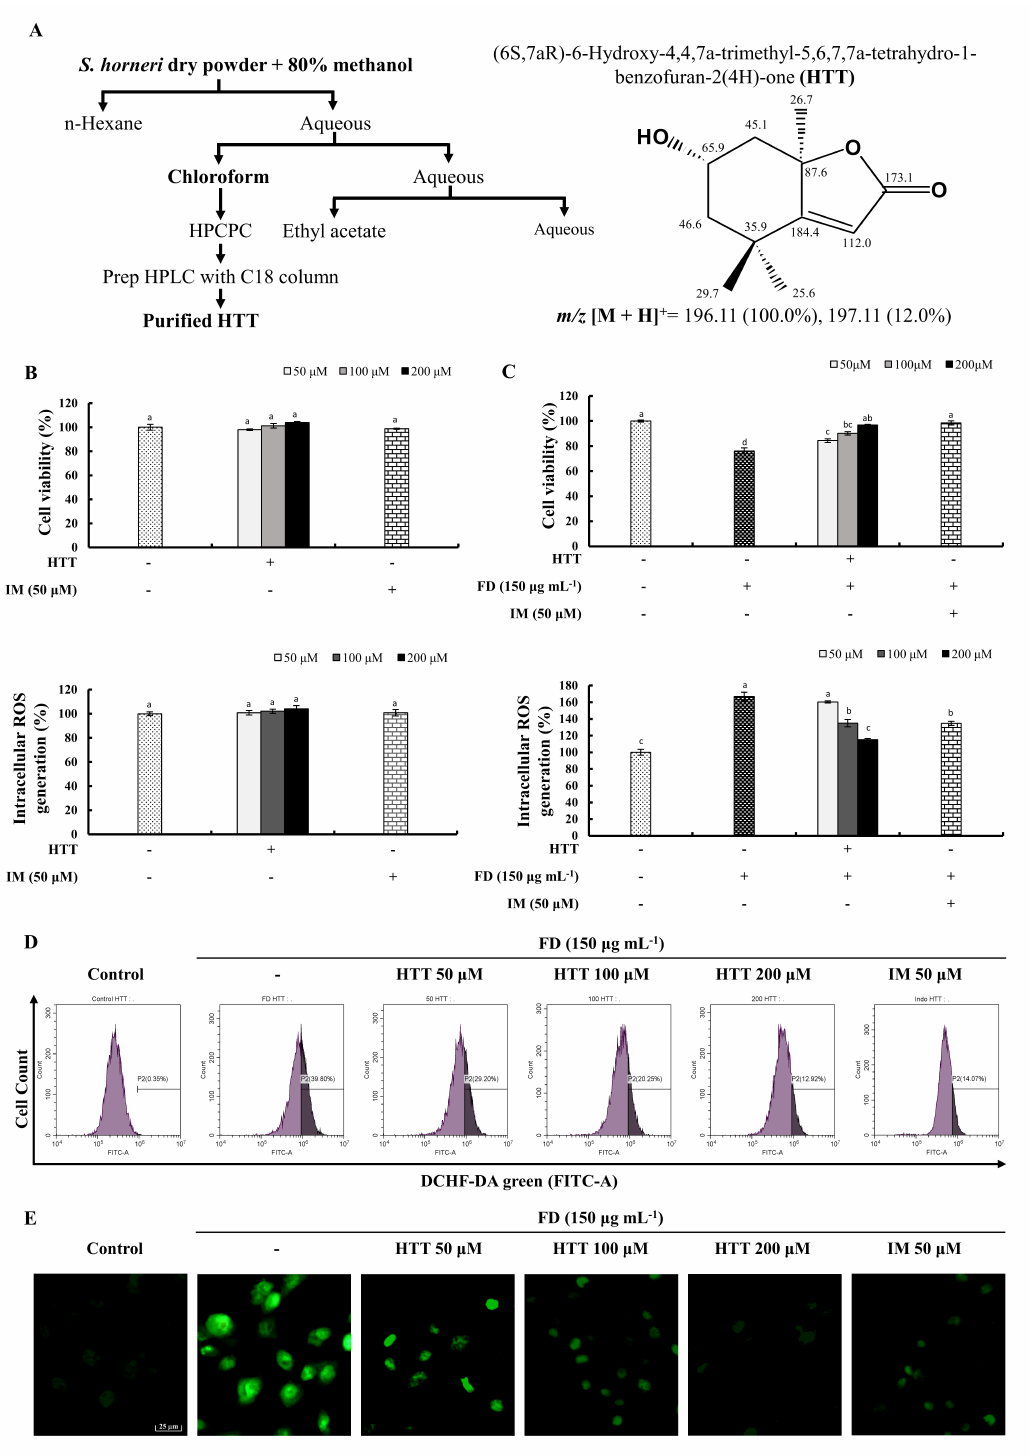
Figure 1. ( A ) Purification process and the chemical structure of (–)-loliolide (HTT) with 1 H NMR chemical shifts. The e ff ects of HTT on cell viability and intracellular reactive oxygen species (ROS) production ( B ) in the absence of fine dust (FD) and ( C ) with FD-stimulated HaCaT cells. Analysis of ROS levels in 2 (cid:48) ,7 (cid:48) -dichlorofluorescin diacetate (DCFH-DA)-stained HaCaT cells by ( D ) flow cytometry and ( E ) fluorescence microscopy. Seeded cells were pre-treated with di ff erent concentrations of HTT (50–200 µ M) at one hour prior to stimulation with 150 µ g mL − 1 of FD. Indomethacin (IM) was used as the positive control. The experiments were conducted in three independent determinations ( n = 3), and the values are given as means ± SEM. Error bars with di ff erent letters are significantly di ff erent ( p <